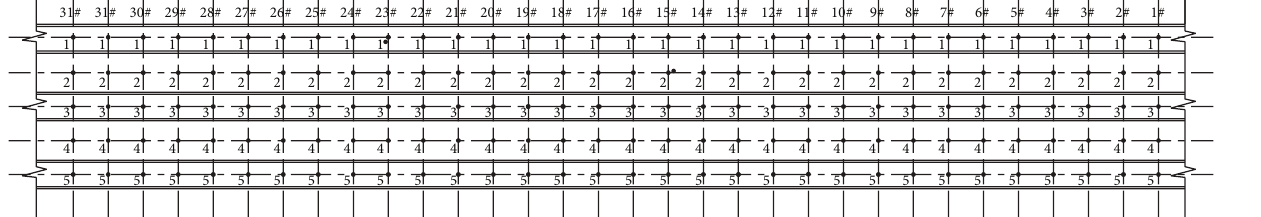
Figure 17: Plane view of the ground settlements monitoring points on a standard section.